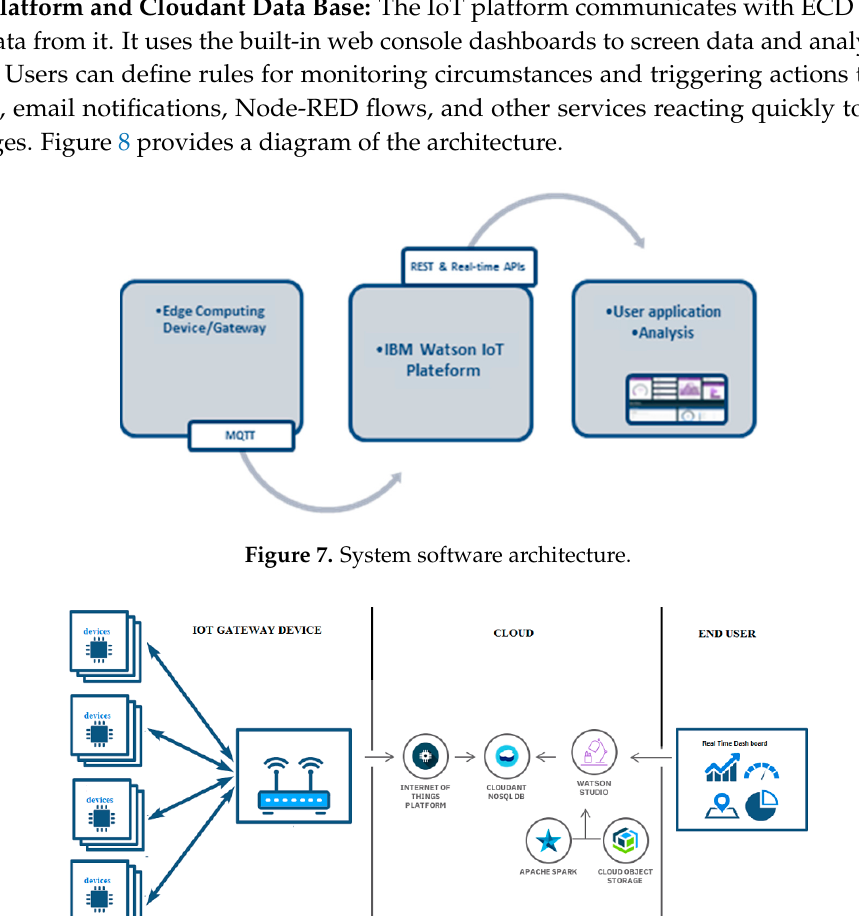
Figure 8. IoT architecture employing cloud services.